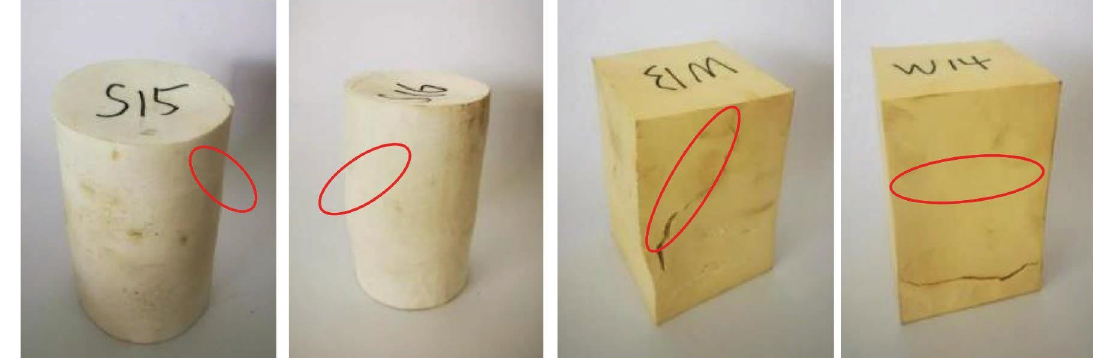
Figure 14: Sample picture after loading failure.